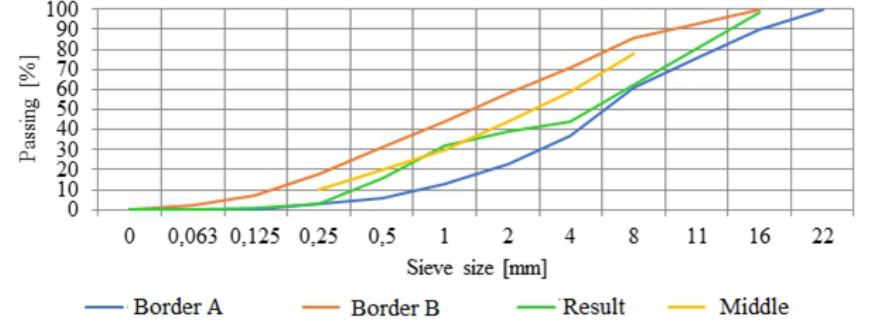
Figure 1. Design of aggregate according to Kennedy Bolomey curve.